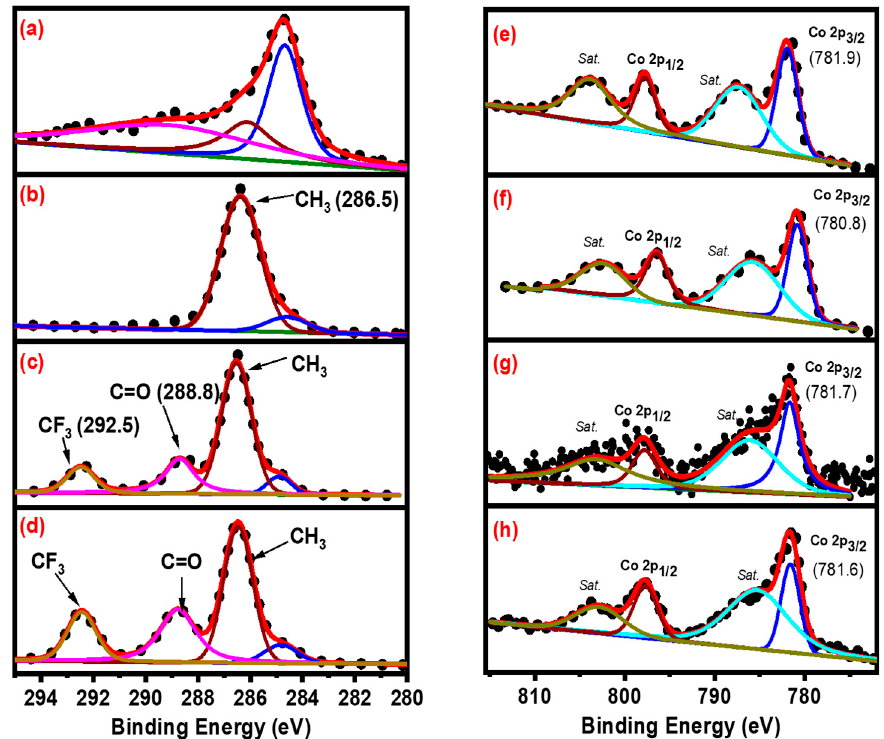
Figure 4. C1s and Co2p XPS analyses of CoCl 2 reagent ( a , e ), [Me 4 N] 2 CoCl 4 ( b , f ), pink solid isolated from [Me 4 N] 2 CoCl 4 -catalyzed reaction ( c , g ), and CoTFA 4 (Me 4 N) 2 synthesized from [Me 4 N] 2 CoCl 4 and AgTFA ( d , h ).